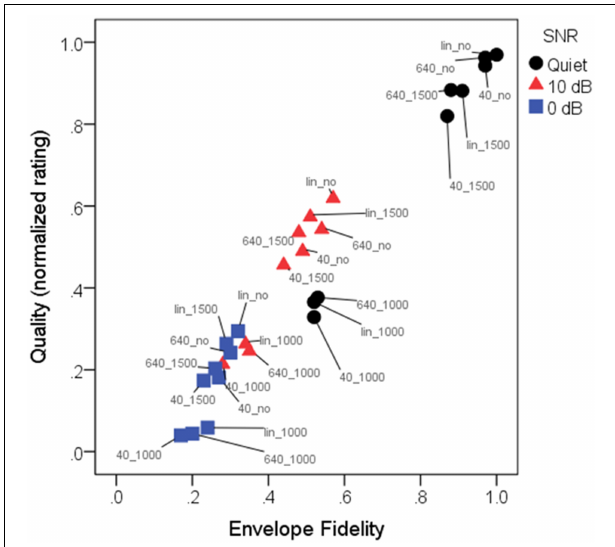
FIGURE 9 | Mean normalized quality ratings as a function of envelope fidelity. Pearson product-moment correlation was 0.97, indicating that the envelope fidelity measure was a good predictor of quality ratings. Each condition is indicated by a color-label combination. Symbols indicate the three SNRs: quiet (black circles); 10dB SNR (red triangles); 0dB (blue squares). Labels indicate the conditions, where 40_, 640_, and lin_ represent WDRC release time or linear amplification, and _1000, _1500, or _no represent frequency compression cutoff frequency or no FC. As quantified by the envelope fidelity metric, the highest-fidelity condition was linear amplification without frequency compression for speech in quiet, and the lowest-fidelity